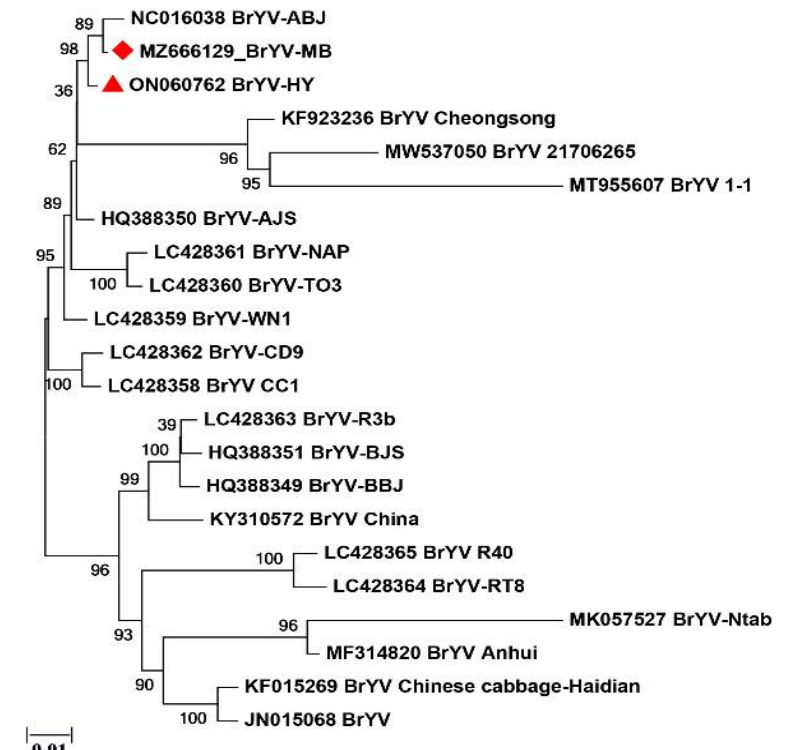
Figure 2. Phylogenetic relationship of the BrYV strawberry isolates with other isolates from brassica. The phylogenetic tree was constructed by MEGA version 7 using the neighbor-joining method with 1000 bootstrap replications based on the full-length nucleotide sequences. Sequences obtained in this study are marked with the red diamond and triangle.